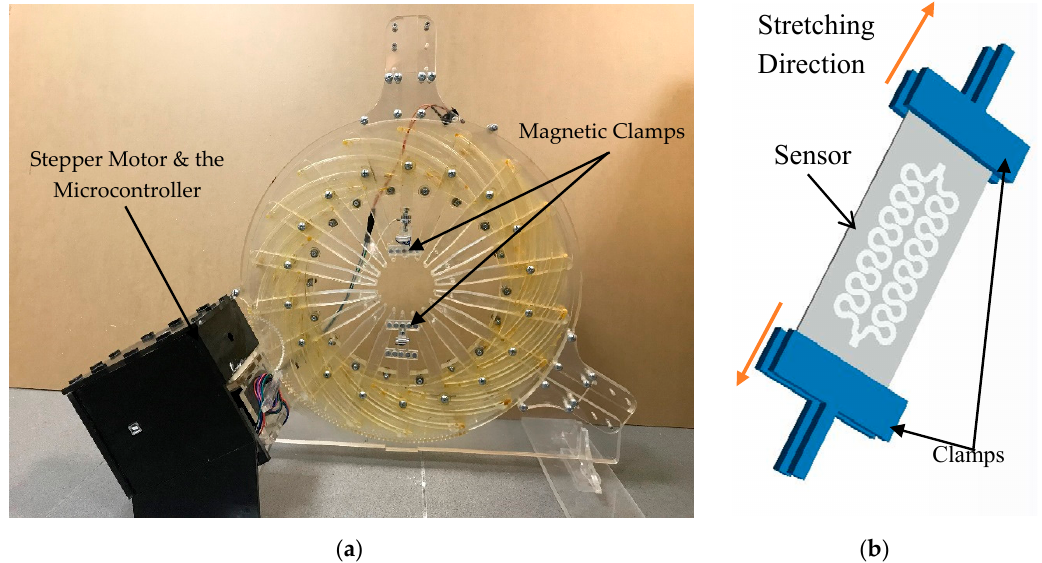
Figure 7. Automated stretching system: ( a ) whole setup and ( b ) sensor mounted using the magnetic clamps.